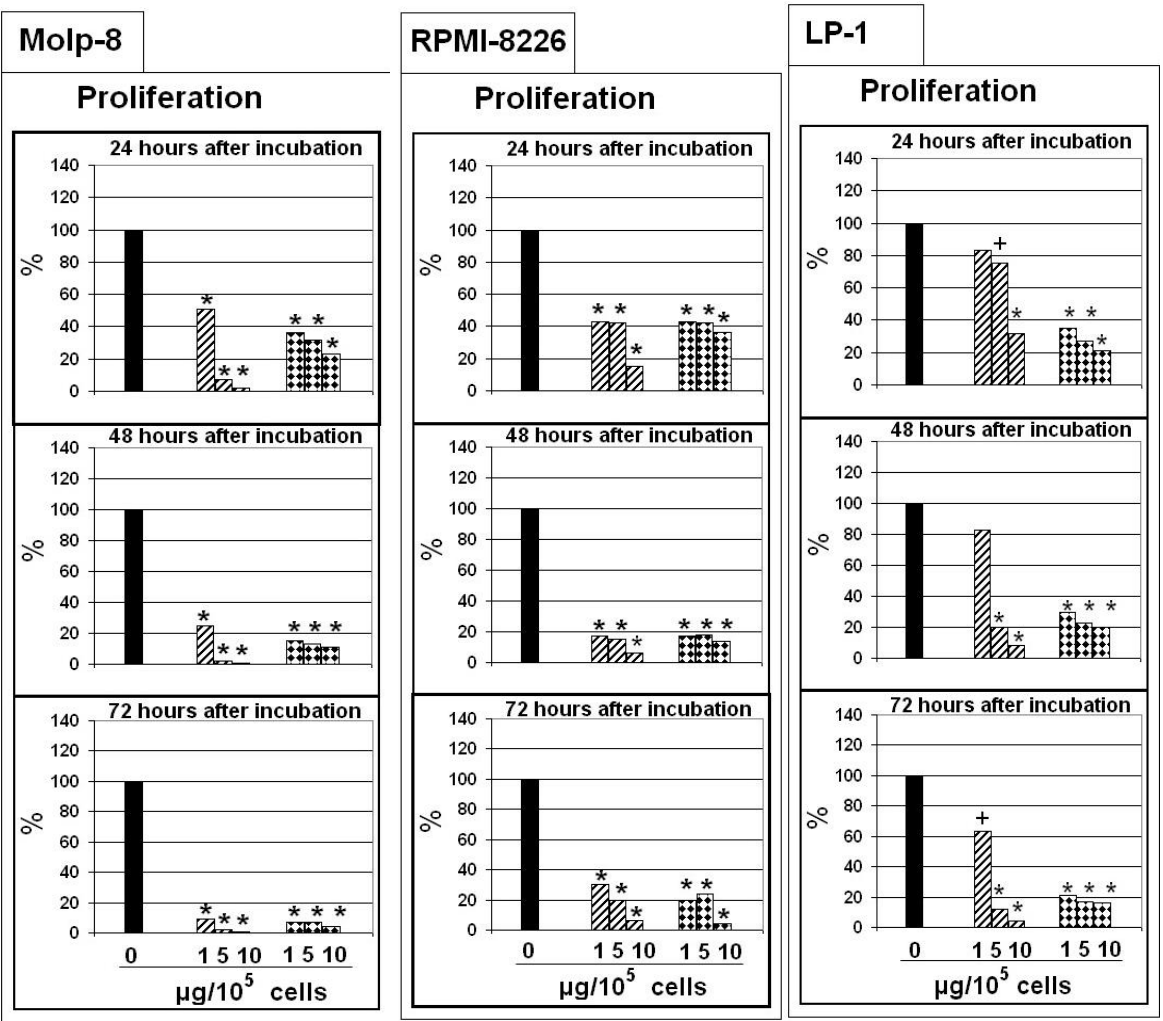
FIGURE 1. The effects of VAQuFrF extract (diagonal slash) or vincristine (diamond pattern) on the proliferation of the human multiple myeloma cell lines Molp-8, LP-1, and RPMI-8226. For the proliferation assay, the cells were cultured of a density of 0.5–07  10 5 cells/100  l. After 24 h, the cells were treated with the test substances for 24, 48, and 72 h. The mean values of four or five independent experiments are expressed as percentage of untreated samples (100%). + p < 0.05, * p < 0.01 compared with untreated samples (Mann-Whitney U-test).